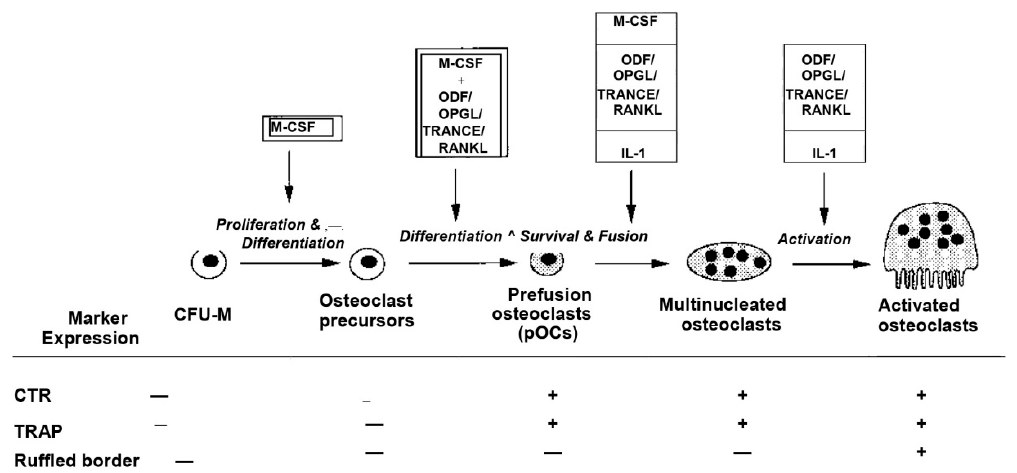
Figure 3. The pathways and cytokines involved in the differentiation of osteoclast progenitors into functionally active osteoclast. With permission from Reference [58]. CTR: calcitonin receptors, TRAP: tartrate-resistant acid phosphatase.